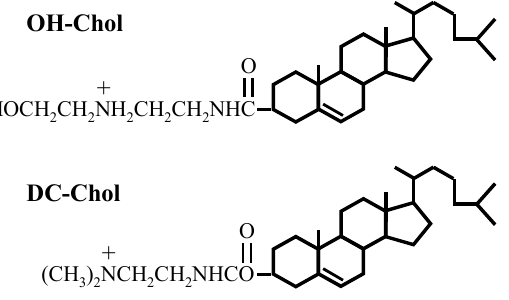
Figure 1. Structures of cholesteryl-3 β -carboxyamidoethylene- N -hydroxyethylamine, OH-Chol and commercially available cationic cholesterol DC-Chol (lower).